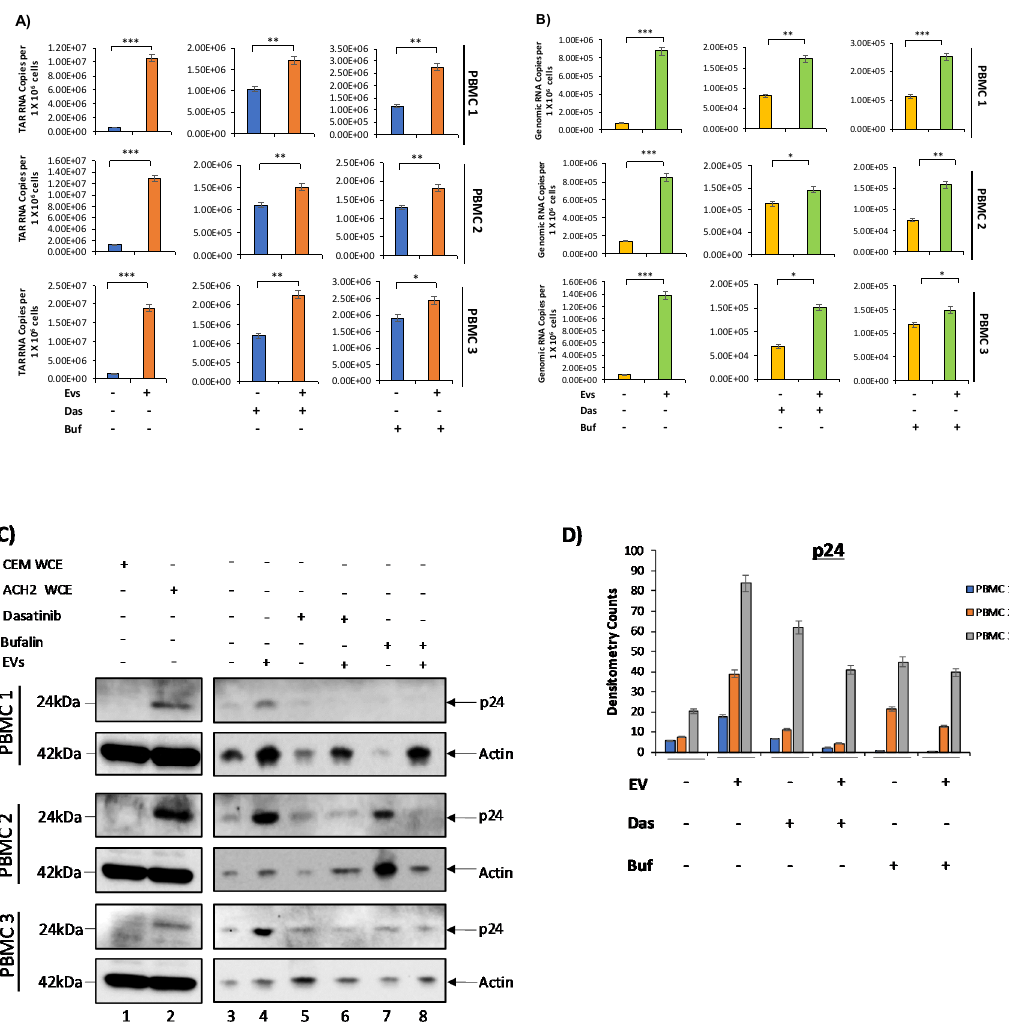
Figure 5. Effects of dasatinib and bufalin on PBMCs treated with cART. Three samples of HIV-1-infected, latent PBMCs were treated with 2.5 nM and 0.5 µM of bufalin and dasatinib, respectively, prior to incubation at 37 °C for 2 h. EVs isolated via ultracentrifugation from each of the PBMCs prior to infection with HIV-1 (89.6) were added back to each of their respective PBMCs. The total ratio of cells to EVs was 1:5000. Cells were then harvested after 72 h of incubation at 37 °C. Total RNA was isolated and subjected to RT-qPCR from cell pellets for HIV-1 TAR ( A ) and genomic RNA ( B ). ( C ) Virions were concentrated from cell supernatant using NT86 and NT80/82 and rotated overnight at 4 °C. Samples were Western blotted for p24. Densitometry counts normalized to actin across all samples are shown for p24 ( D ). CEM and ACH2 WCE were used as a negative and positive control, respectively. Actin was used as a loading control. Student’s t-test compared untreated cells with cells treated with drugs. *, p < 0.05; **, p < 0.01; ***, p < 0.001. Error bars, S.D.